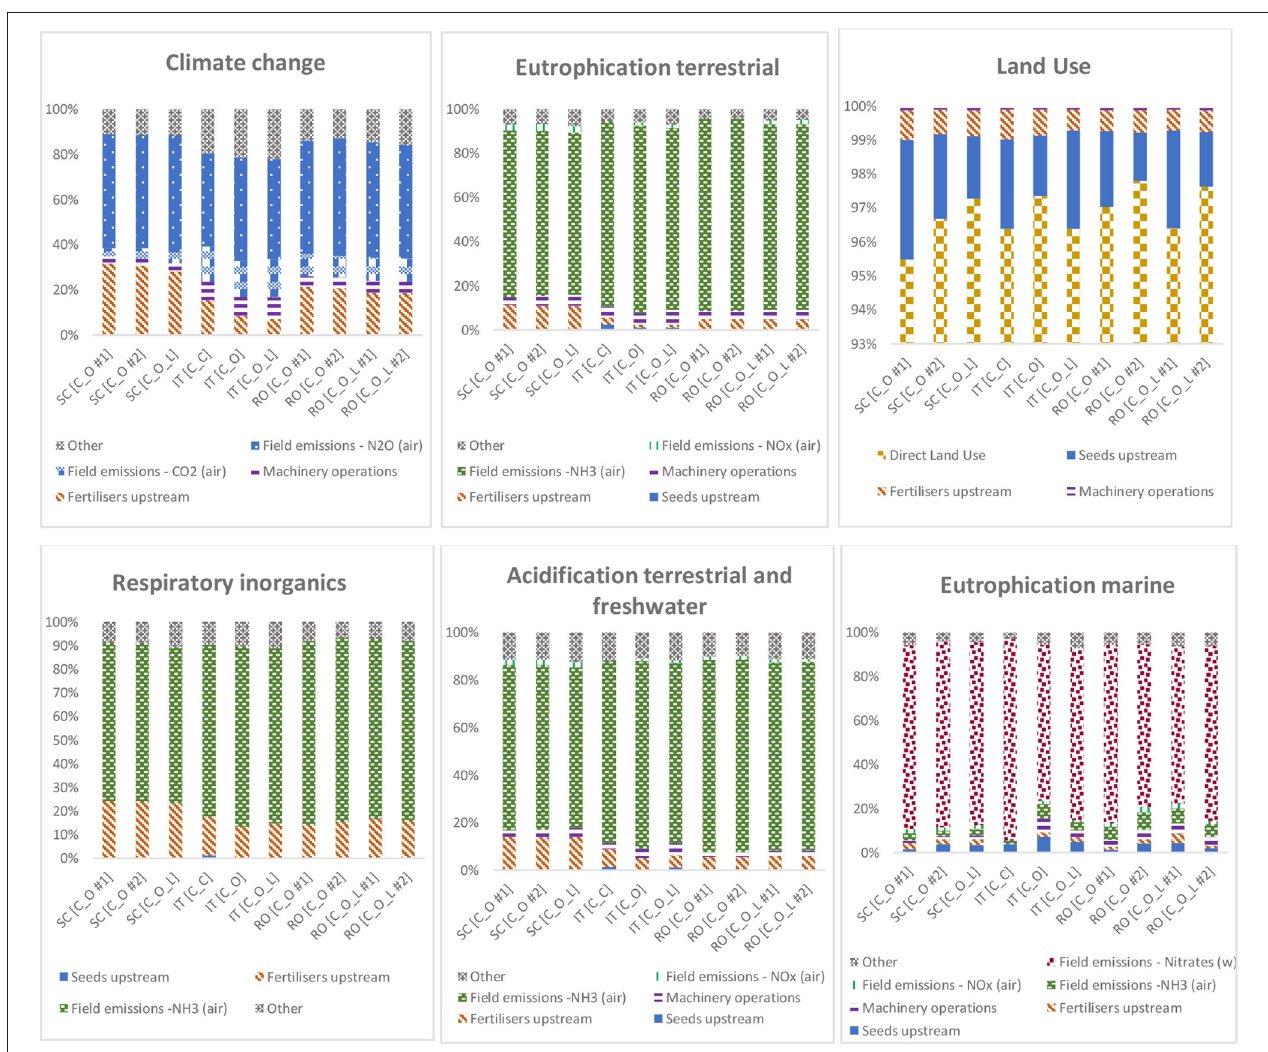
FIGURE 2 | Process contributions for the six priority impact categories across the ten rotations of cereal (C_), oilseed (_O_), and legume (_L) in Scotland (SC), Italy (IT), and Romania (RO) for the NDU P − F FU.